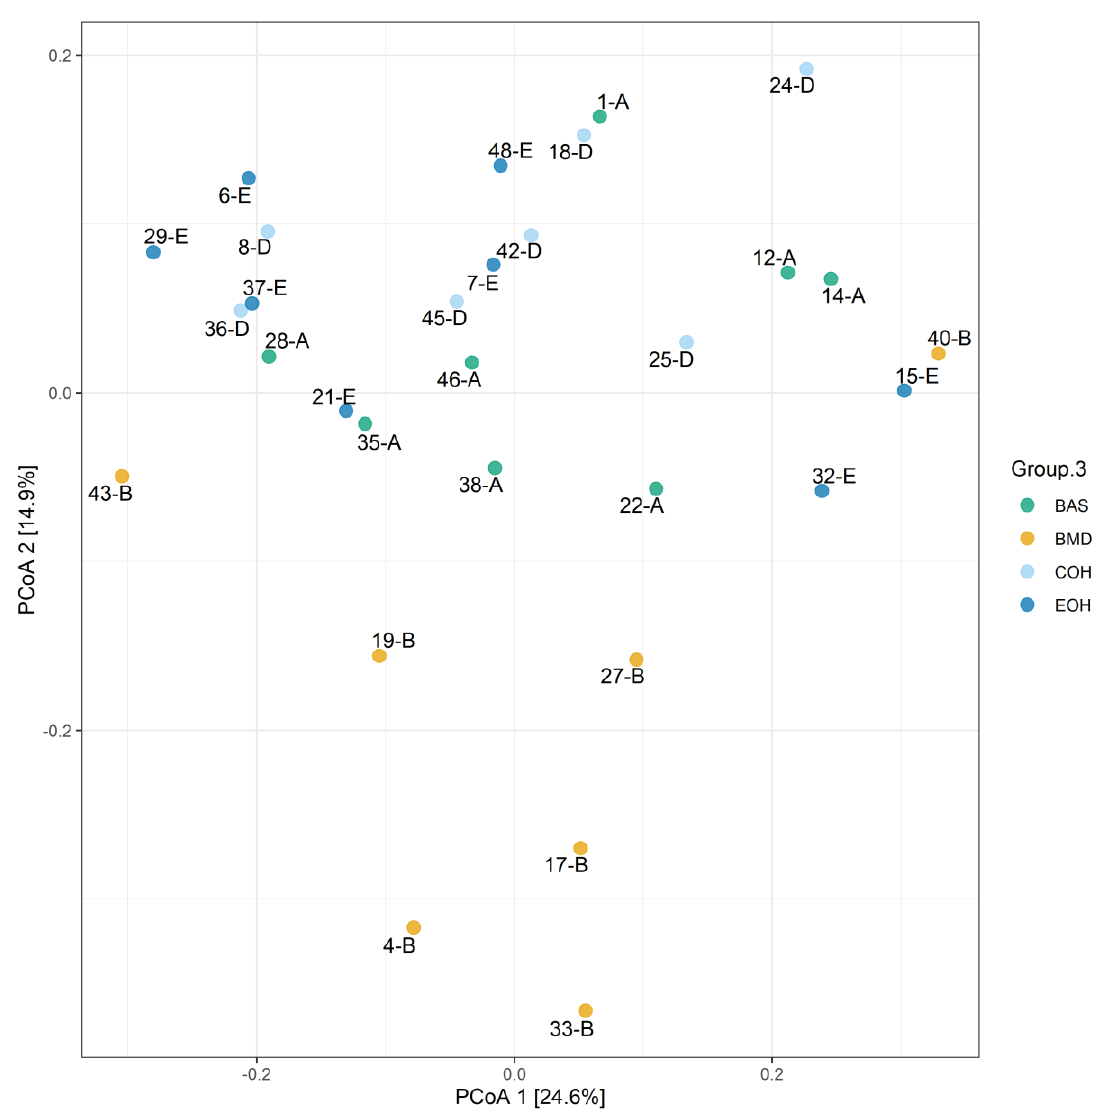
Figure 3. pCoA ordination performed by Bray-Curtis dissimilarities showing the microbiome composition for all specimens. BAS = basal diet; BMD = antibiotic diet; COH = diet supplemented with 3% coarse oat hulls; and EOH = diet supplemented with 3% extruded oat hulls.